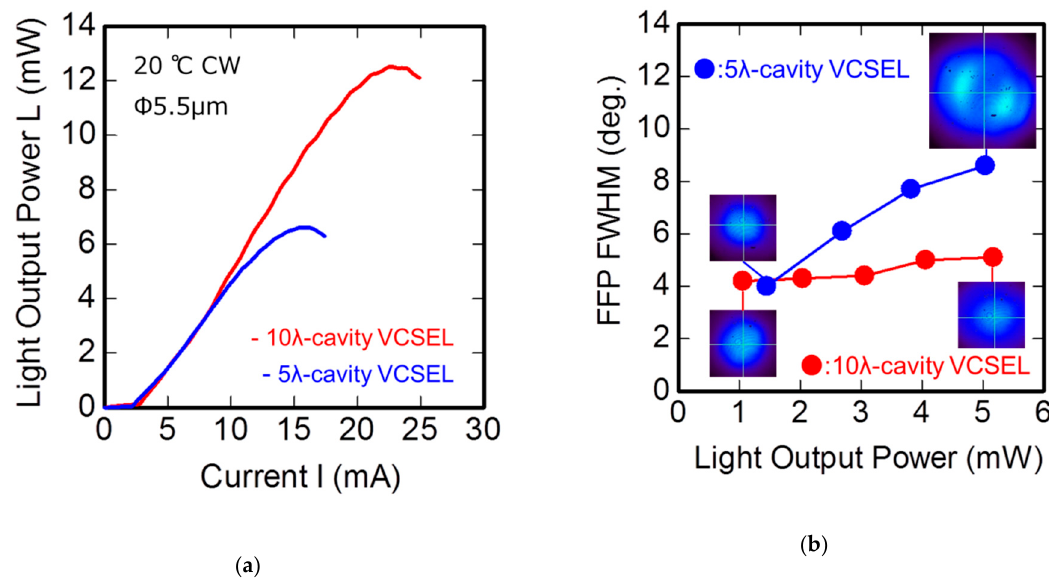
Figure 9. ( a ) I-L characteristics of the 5 λ - and 10 λ -cavity VCSELs with 5.5- μ m aperture under CW operation at 20 °C. ( b ) Full width at half maximum (FWHM) of far field pattern (FFP) of the 5 λ - and 10- λ cavity VCSELs with 5.5- μ m aperture as a function of light output power. The insets show the FFP images at around 1 mW and 5 mW.